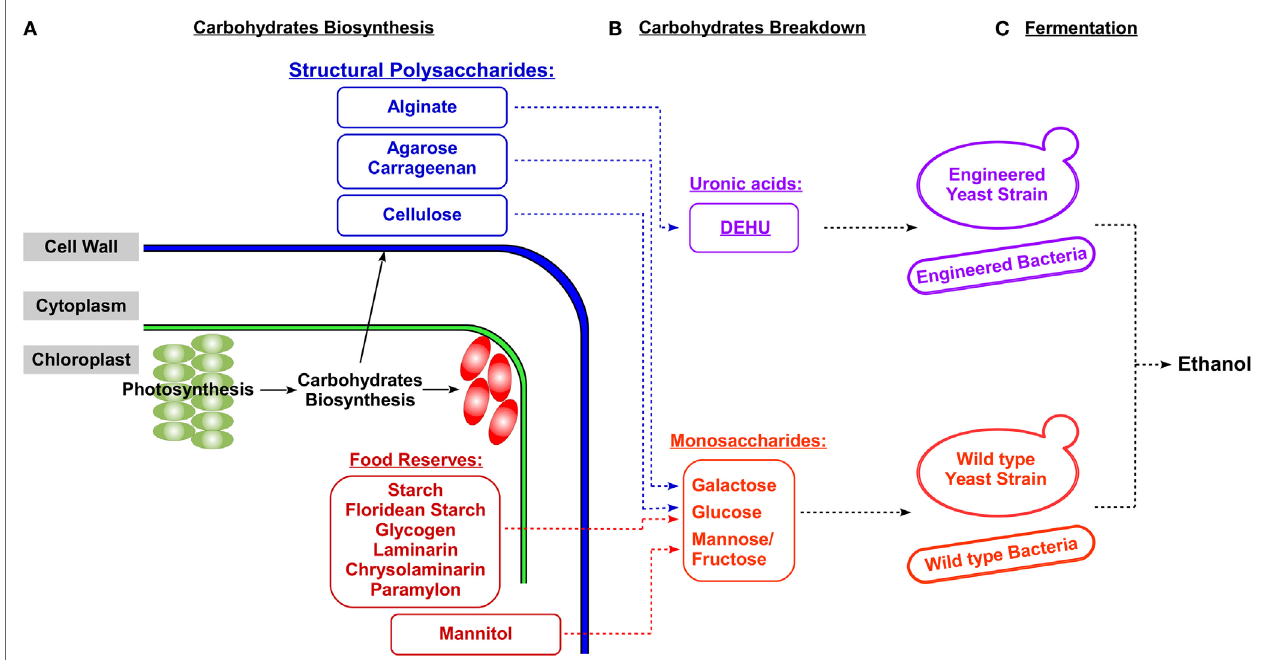
FiGURe 1 | Overview of ethanol production from major algal carbohydrates . (A) Algae store simple sugars in the form of simple and complex food reserves (See Food Reserves) and as structural polysaccharides (See Structural Polysaccharides). (B) Food reserves and structural polysaccharides are degraded into their basic monosaccharides and uronic acids (described in Sections “Conversion of Starch-Type Polysaccharides to Glucose,” “Conversion of Laminarin-Type Polysaccharides to Glucose,” “Conversion of Mannitol to Fructose and/or Mannose,” “Conversion of Cellulose to Glucose,” “Hydrolysis of Agarose to Galactose,” “Conversion of Carrageenan to Galactose,” “Conversion of Alginate to Uronic Acid Monomers,” “Degradation of Ulvans and Fucoidan” and Figure 2 ), which are (C) fermented into ethanol using microbial wild-type strains or their genetically engineered counterparts (See Fermentation of Algal Simple Sugars and Uronic Acids to Bioethanol). The chemical structures of the listed polysaccharides are presented in Table 1 . DEHU, 4-deoxy- l -erythro-5-hexoseulose uronic